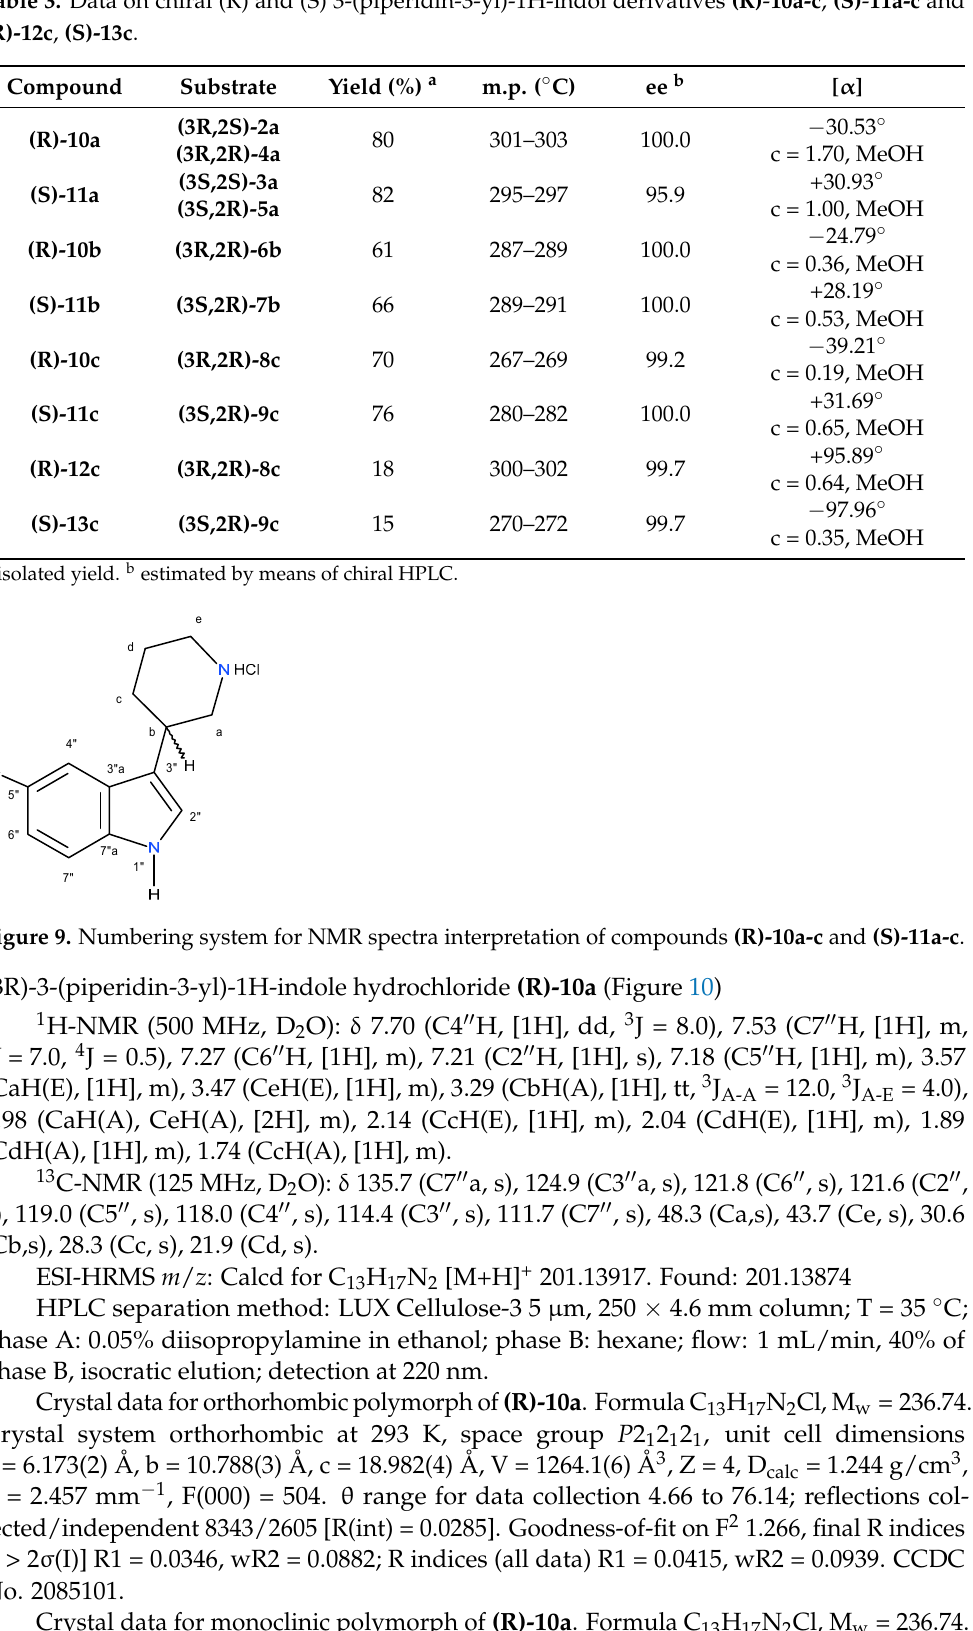
Table 3. Data on chiral (R) and (S) 3-(piperidin-3-yl)-1H-indol derivatives (R) - 10a-c , (S) - 11a-c and